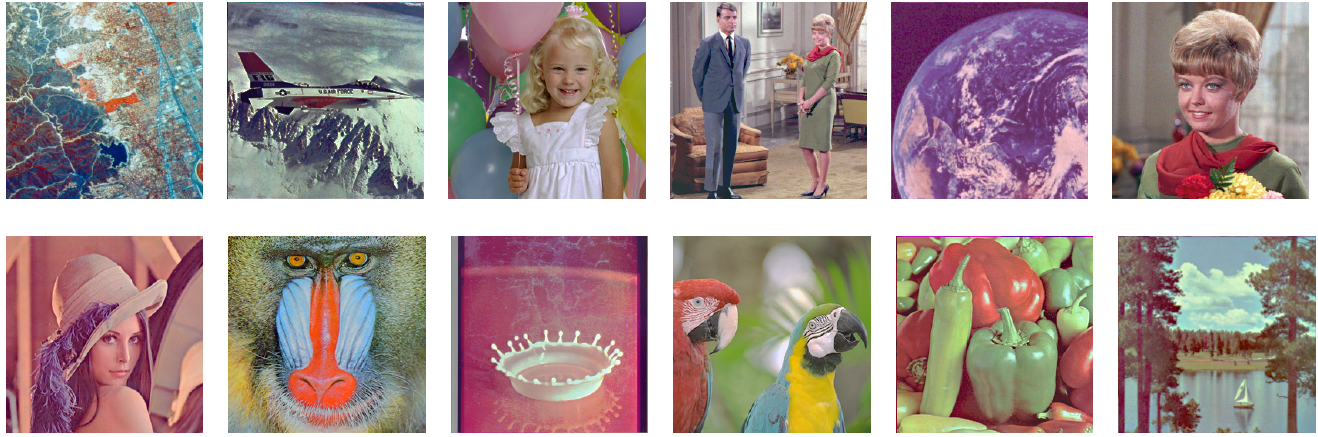
Figure 25. Results of the proposed exact histogram